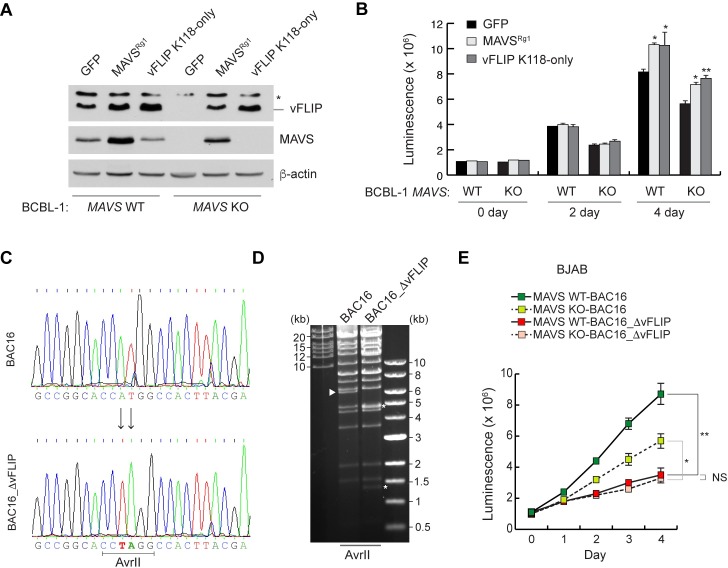
vFLIP expression is required for HHV-8 latent infection.(A) Immunoblots of the extracts from WT and MAVS KO BCBL-1 cells lentivirally transduced with GFP, MAVSRg1, and K118-only vFLIP for 4 days. The asterisk indicates a band of unknown identity. (B) Cell viability assays with the cells seeded at 5x104 cells/ml after 4 day-transduction as in (A). Data are presented as mean ± SD of triplicate samples. (*p<0.005 and **p<0.05) (C) Sequence analysis of the wild-type BAC16 and mutant BAC16_ΔvFLIP genomes. The vFLIP initiation (ATG) codon was substituted with a stop codon TAG in BAC16_ΔvFLIP, thereby creating a de novo AvrII restriction site. (D) Agarose gel electrophoresis of wild-type BAC16 and recombinant BAC16_ΔvFLIP genomes. DNAs were digested with AvrII and resolved on a 0.5% agarose gel stained with ethidium bromide. As predicted from AvrII restriction pattern, the 6,178 base pairs (bp) fragment (arrow head) was fragmented into two segments 1,384 and 4,794 bp (asterisks). (E) Growth curve of WT and MAVS KO BJAB cells infected with wild-type BAC16 and mutant BAC16_ΔvFLIP viruses. Cell viability was assessed by determining ATP levels using CellTiter-Glo for 4 days. Data are presented as mean ± SD of two independent experiments in triplicate. (*p<0.005; **p<0.05; and ns, not significant).